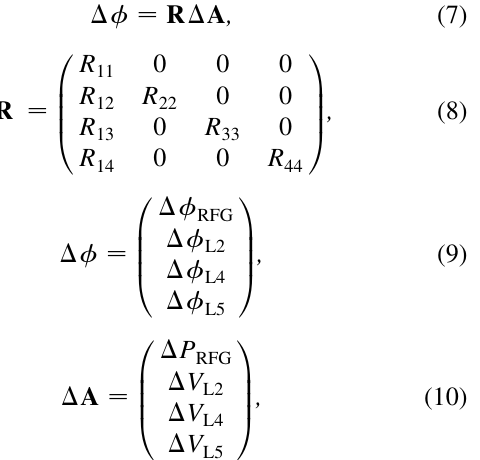
FIG. 8. (Color) Linac phase feedback operation for the case of an induced phase error due to momentarily changing the rf gun power from its nominal value. Shown is the klystron forward power, which is applied to the rf gun after being attenuated. The feedback loop is turned on approximately 60 seconds into the test. As expected, the L2, L4, and L5 phase actuators are changed only